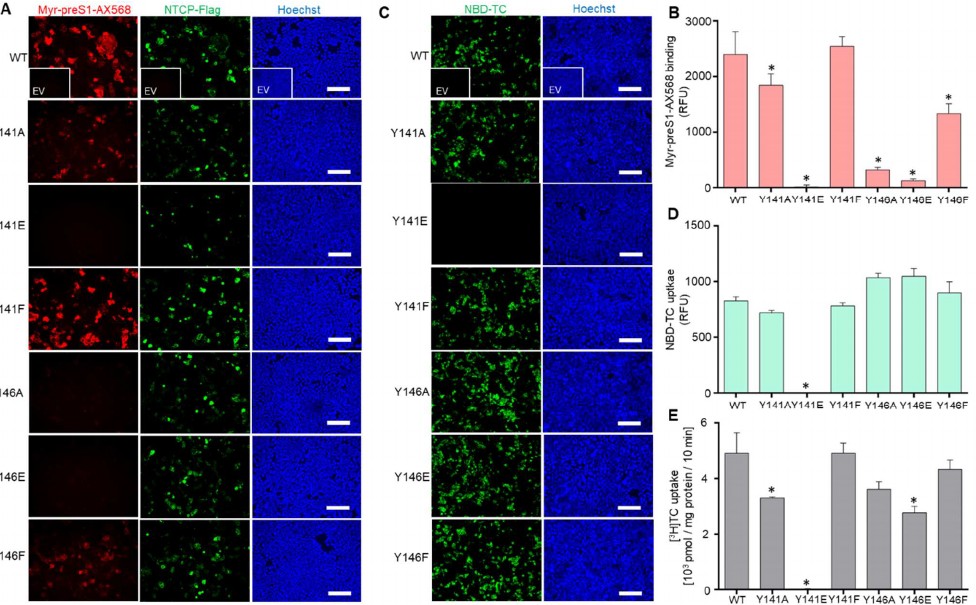
Figure 4. Bile acid transporter function and HBV/HDV myr-preS1 receptor function of the tyrosine 141 and 146 NTCP mutants. ( A ) Binding of the fluorescently labeled viral myr-preS1-AX568 peptide (red, 50 nM incubated for 20 min at 37 °C) was analyzed using florescence microcopy in HEK293 cells transiently transfected with the indicated NTCP mutant constructs. Successful NTCP- expression was confirmed by using rabbit anti-FLAG primary and Alexa Fluor 488-labelled goat anti-rabbit secondary antibodies (green). Nuclei were stained by Hoechst 33342 (blue). Scale bars: 130 µm. Representative fluorescence images are shown. ( B ) For quantification of myr-preS1-AX568 peptide binding to NTCP, fluorescence images were captured on Leica DMI6000 B fluorescent microscope and fluorescence signals were quantified with the LAS-X imaging software (Leica) by determining cell-based fluorescence in defined regions of interest (ROI). Data are presented as mean background-subtracted relative fluorescence units (RFU). ( C ) Bile acid transport activity of HEK293 cells overexpressing wt NTCP and the indicated mutant NTCP proteins was analyzed using 5 µM NBD-TC incubated as NTCP substrate for 30 min at 37 °C (green). Nuclei were stained by Hoechst 33342 (blue). Scale bars: 130 µm. ( D ) For quantification of NBD-TC transport into NTCP-expressing HEK293 cells, fluorescence images were quantified with the LAS-X imaging software (Leica) by determining cell-based fluorescence in defined regions of interest (ROI). Data are presented as mean background-subtracted relative fluorescence units (RFU). ( E ) Quantitative analysis of bile acid uptake into HEK293 cells overexpressing wt and mutant NTCP proteins by using radioactive- labelled [ 3 H]TC. Data represent means ± SD for three independent experiments. EV, empty vector. * Significantly lower compared to wt NTCP with p < 0.001 according to one-way ANOVA with Dunnett’s multiple comparison post-hoc test.